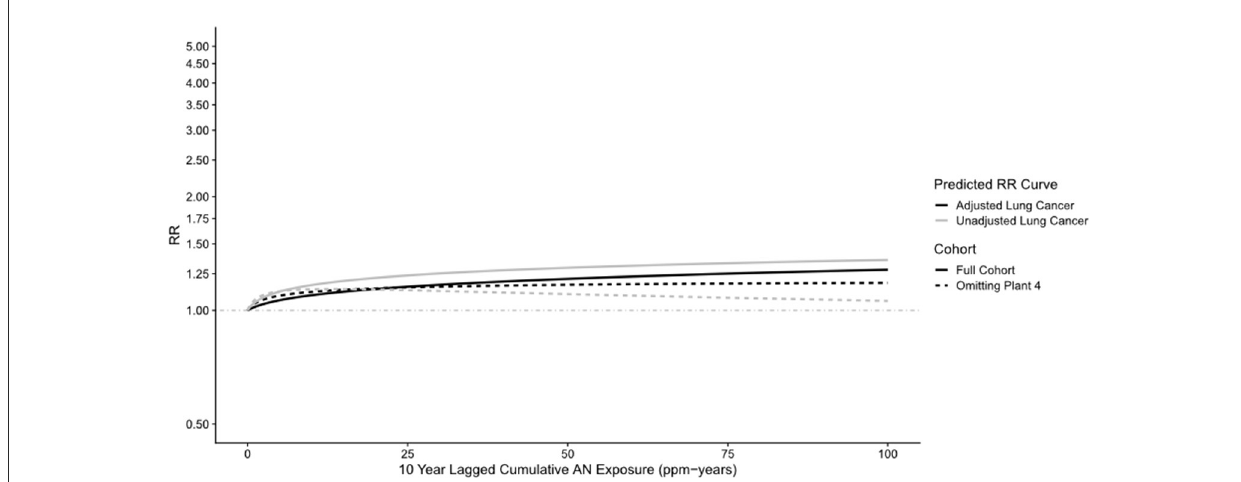
FIGURE5 UPitt lung cancer relative risk: full cohort vs. omitting plant 4—unadjusted and adjusted for smoking using the Richardson method (continuous data).